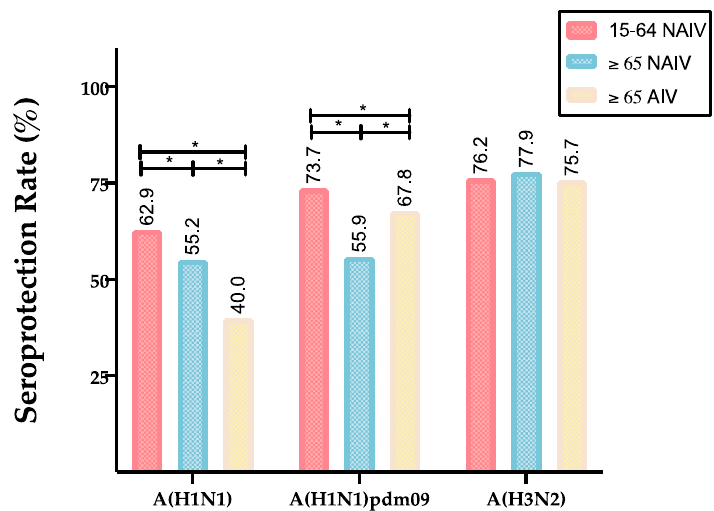
Figure 1. Pre-vaccination SPR of each cohort against each strain / subtype of influenza A. The line Figure 1. Pre-vacCI nation SPR of each cohort against each strain/subtype of influenza A. The line marked with * represent statistically significant ( p < 0.05) di ff erences between those two cohorts. marked with * represent statistically significant ( p < 0.05) differences between those two cohorts.